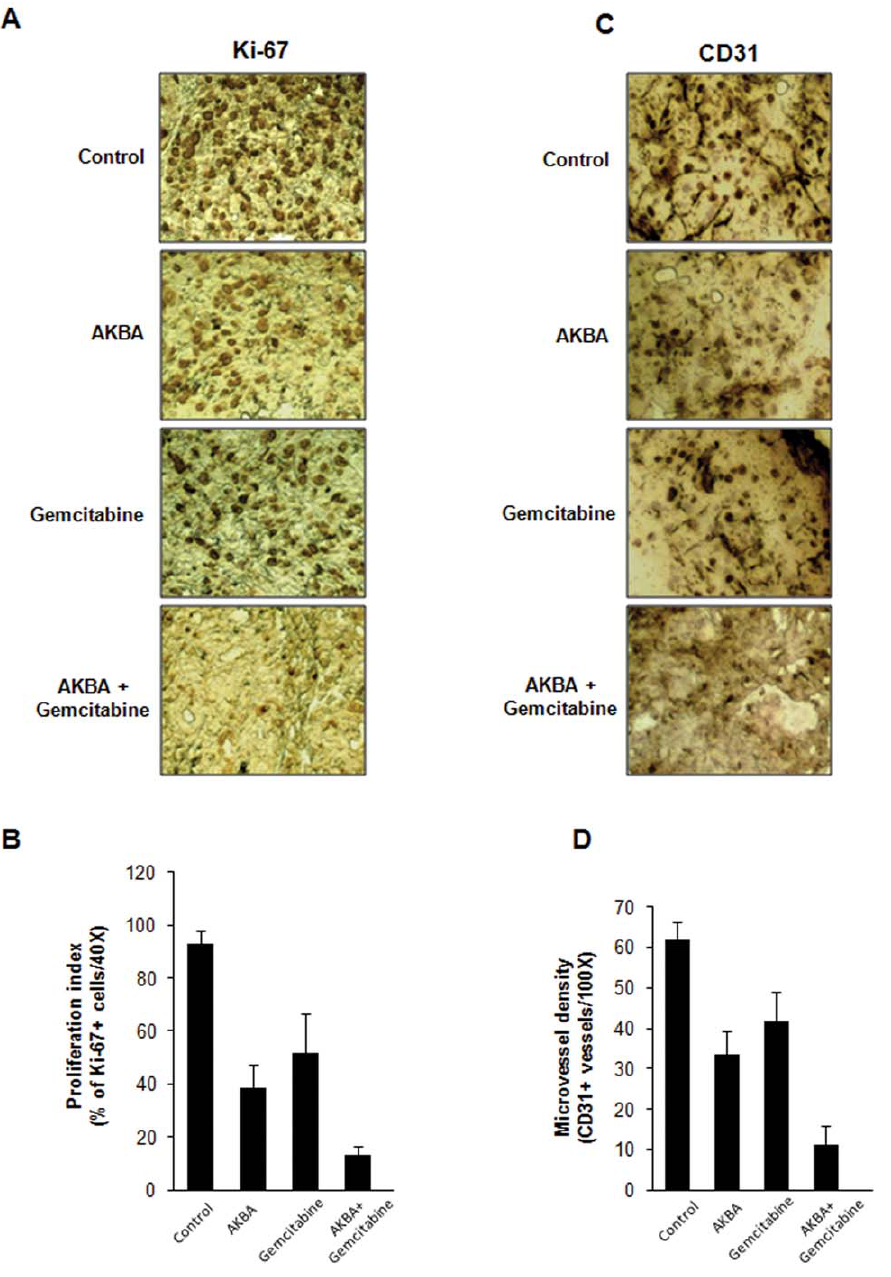
Figure 4. AKBA enhances the effect of gemcitabine to inhibit tumor cell proliferation and angiogenesis in PaCa. A, the results of an immunohistochemical analysis of proliferation marker Ki-67 indicated that PaCa cell proliferation was inhibited in mice treated with AKBA alone and in combination with gemcitabine. B, quantification of Ki-67 positive cells was described in Materials and Methods . Columns, mean; bars, SE. C, the results of an immunohistochemical analysis of CD31 for microvessel density in PaCa indicated that angiogenesis was inhibited by AKBA alone and in combination with gemcitabine. D, quantification of CD31 positive cells was described in Materials and Methods . Columns, mean; bars, SE.